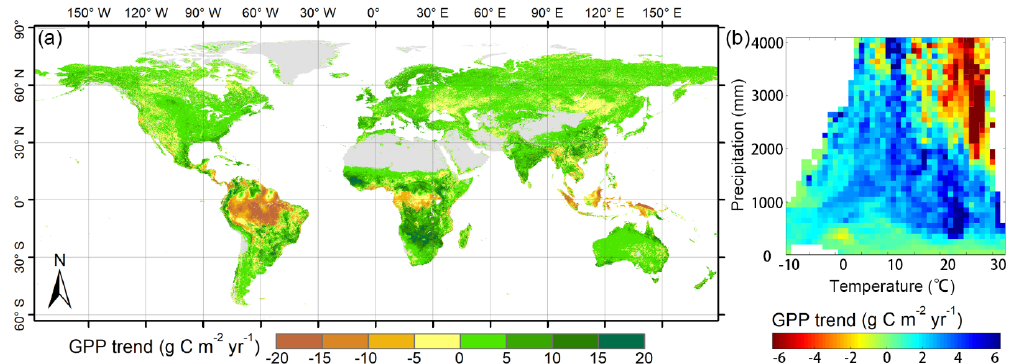
Figure 6. Spatial pattern of global GPP trend simulated by the revised EC-LUE models during 1982–2017: (a) trend of annual GPP; (b) trend of annual GPP at different temperature and precipitation gradients.